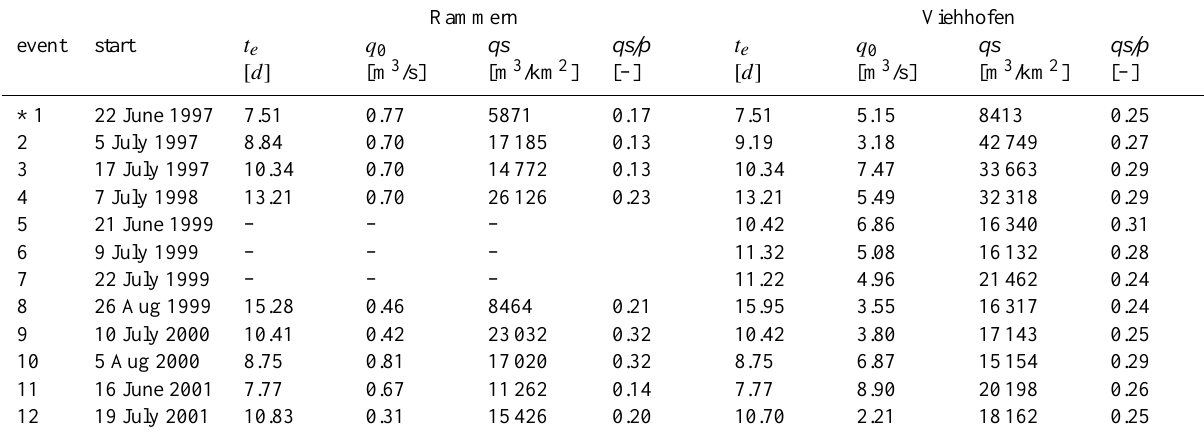
Table 6. Characteristics of the bimodal events measured at gauges Rammern and Viehhofen. Rammern